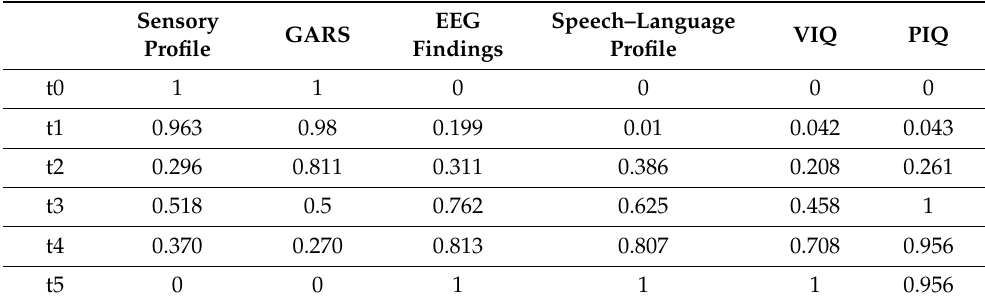
Table 5. Normalized values of sensory profile, GARS, EEG findings, speech–language profile, VIQ, and PIQ in the range of 0 to